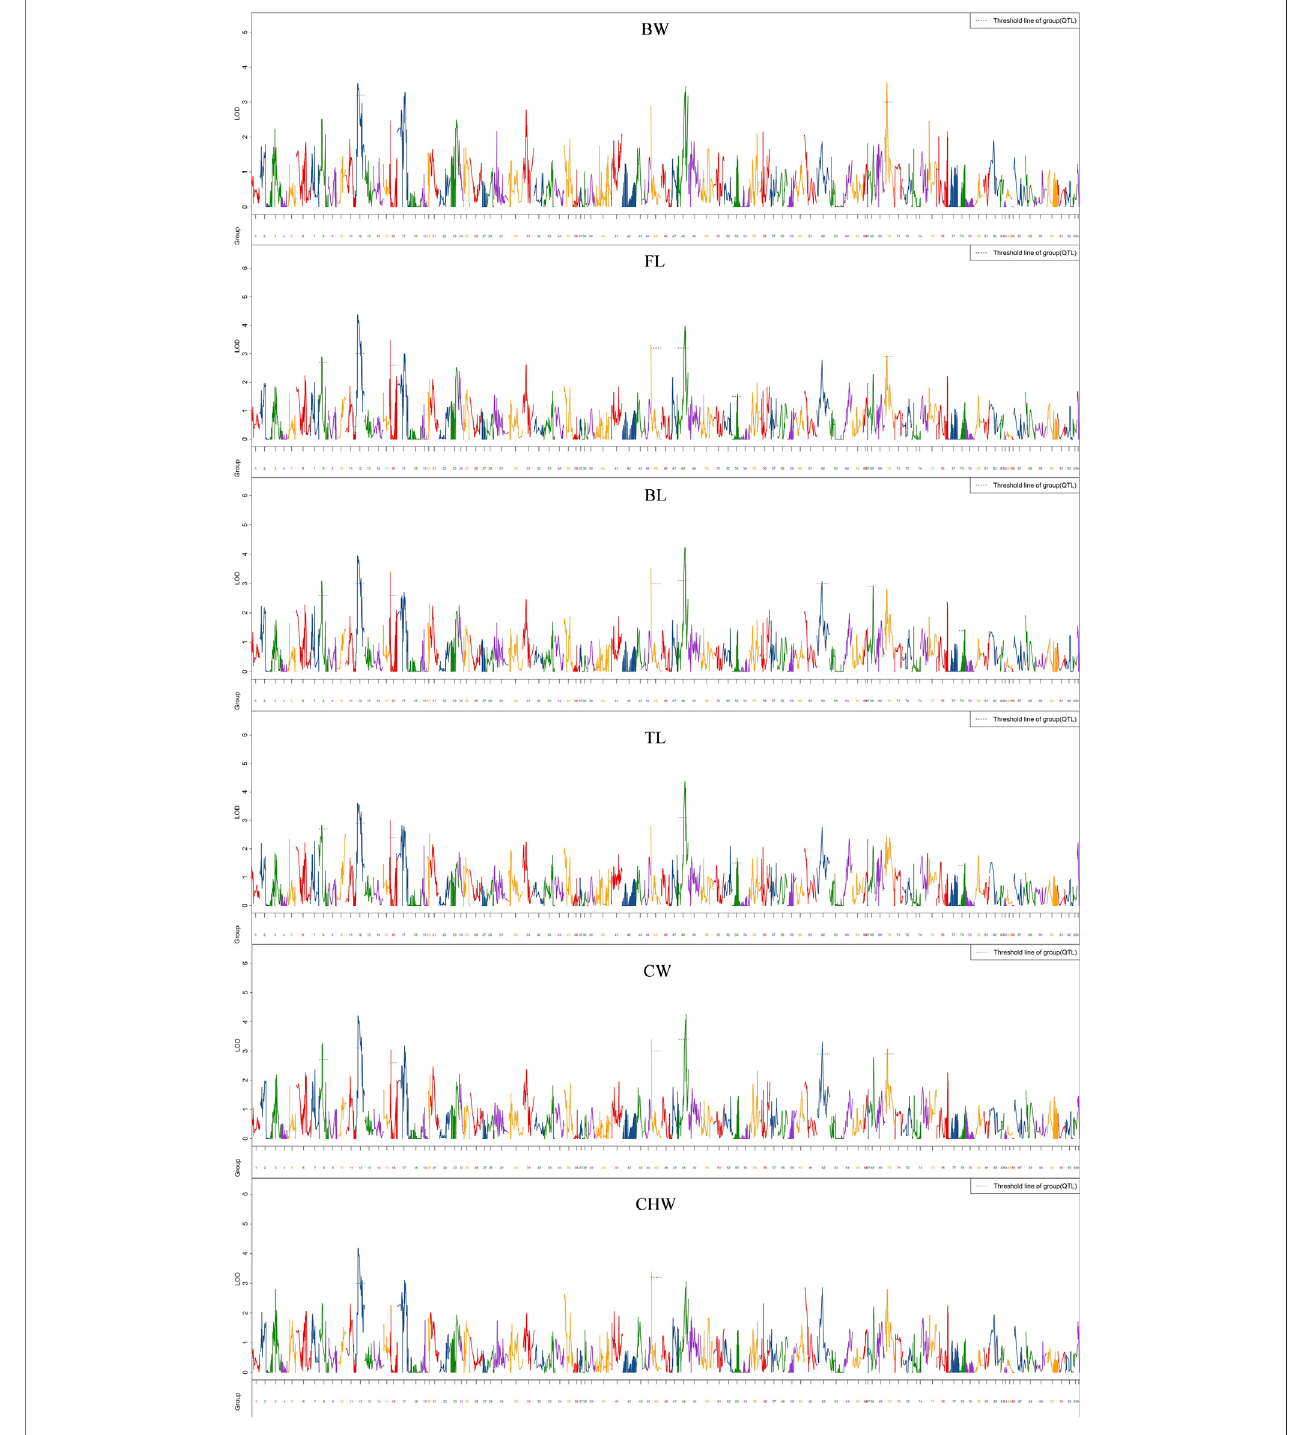
FIGURE 2 | QTL mapping of six growth-related traits of red swamp cray fi sh. The length of each linkage group is plotted as the coordinate distance in the x -axis.